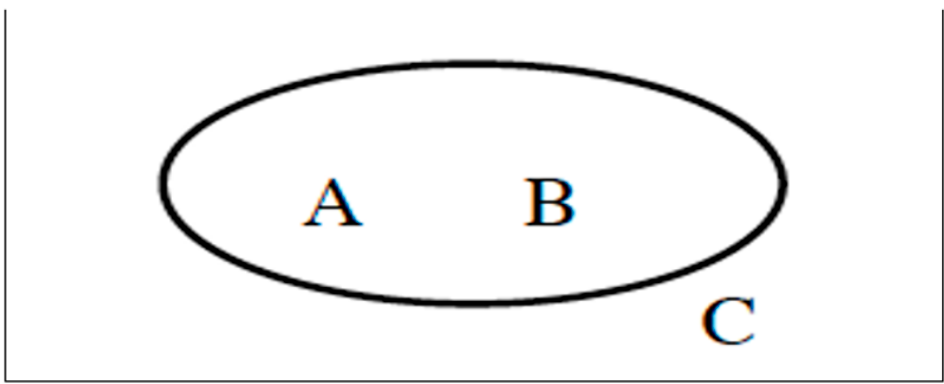
Figure 8. The image schema of SPATIAL ASSOCIATION (reprinted from Langacker 1987).